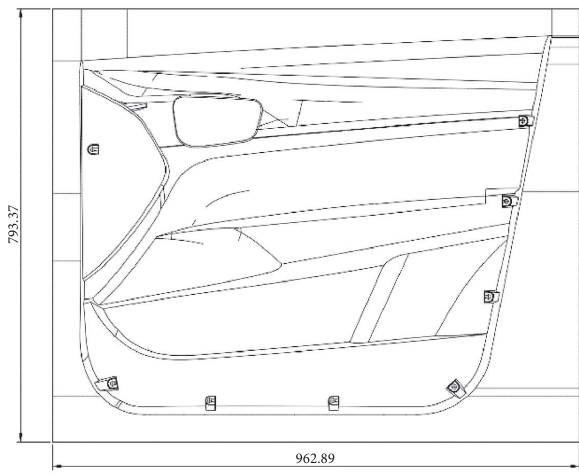
Figure 4: Cavity